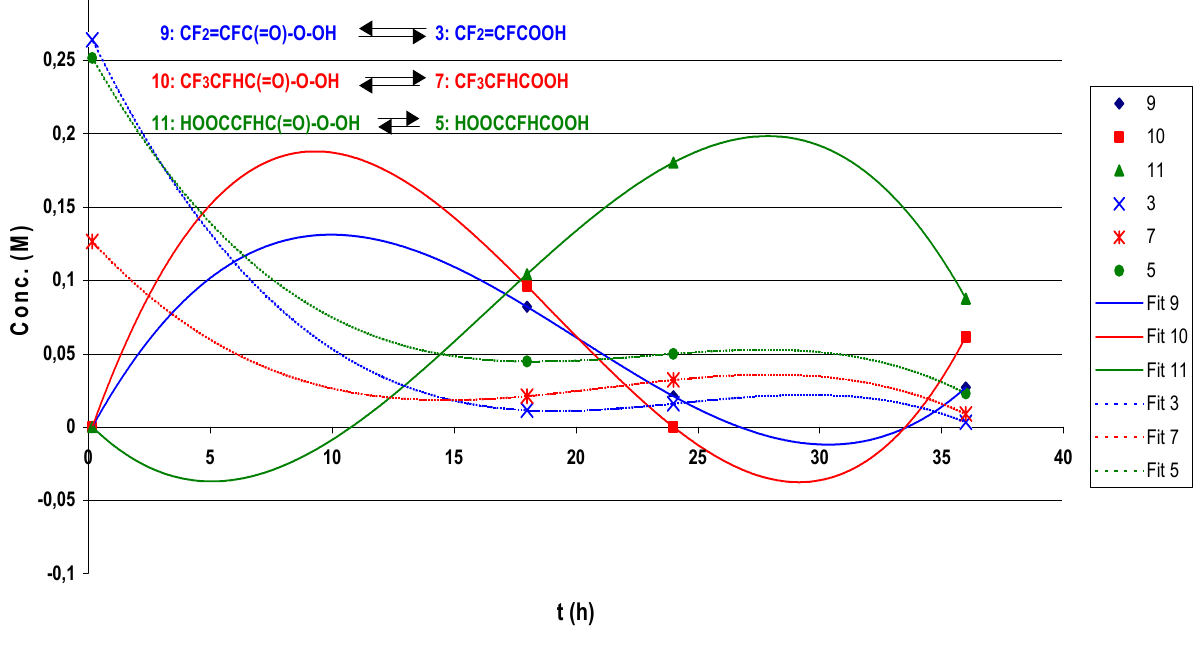
O to FAFS—Acid-peracid 2 2